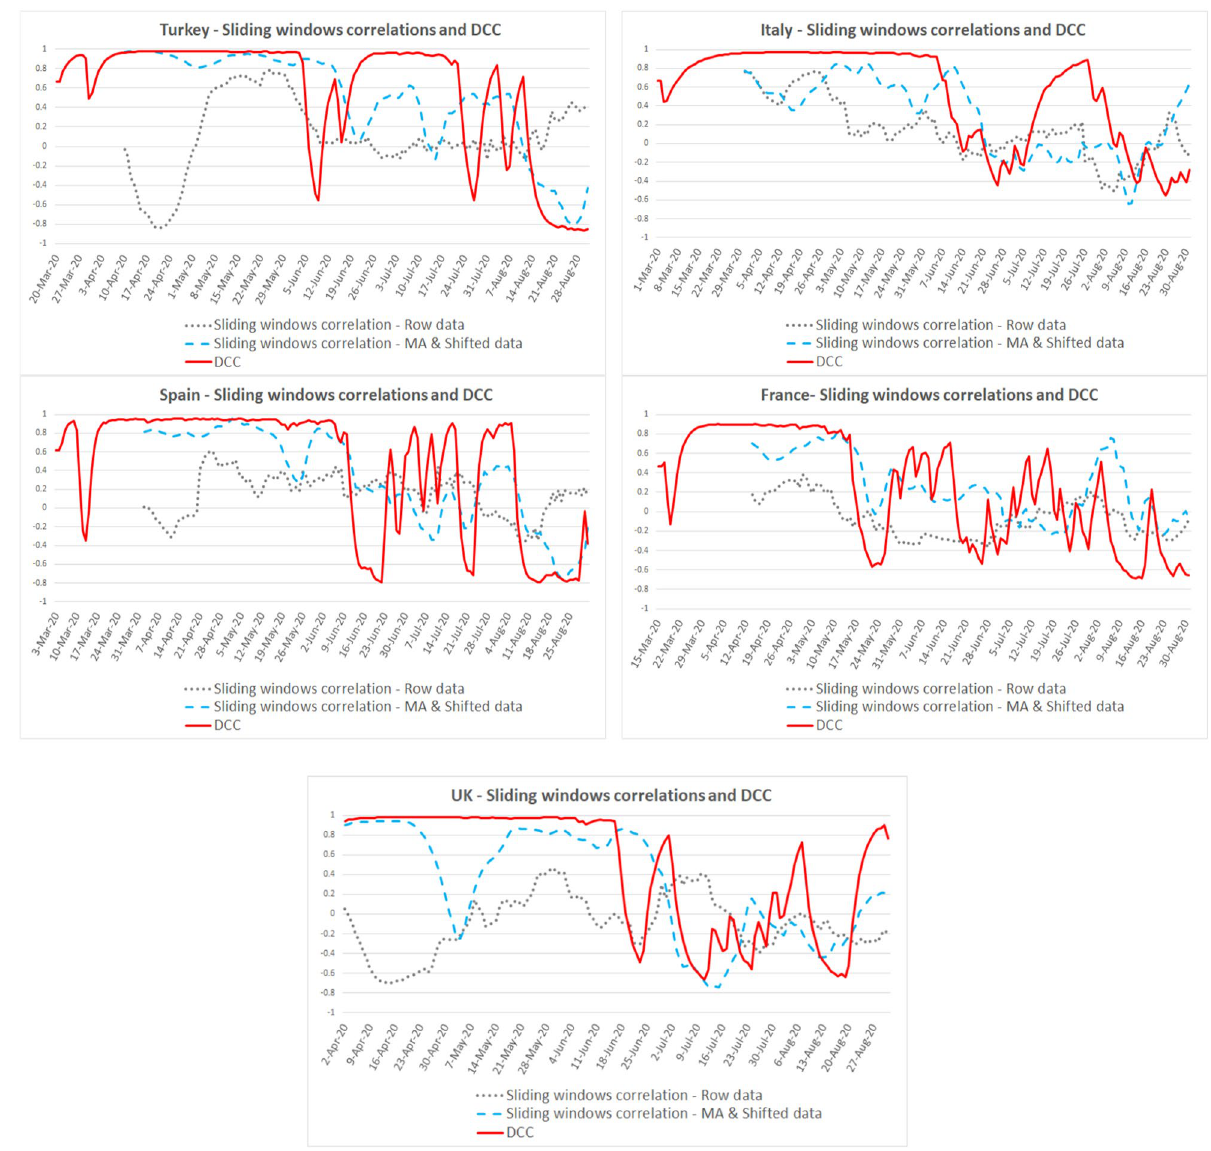
Figure 5. Correlations between dyspnea symptom search and new